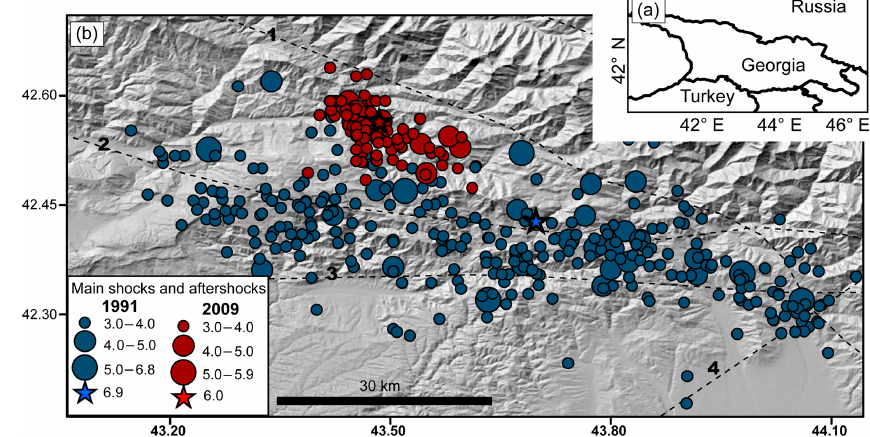
Figure 1. (a) Location of Georgia. (b) Distribution of locations of the Racha main shocks (stars) and aftershocks from 1991 (dark blue dots) and 2009 (dark red dots) with magnitudes greater than 4 (source: the catalog of the Seismic Monitoring Center (SMC) in Georgia, www.seismo.ge). Major faults are shown by black dashed lines (Gamkrelidze and Shengelia, 2007). Numbers on the dashed lines link to the name of the faults. 1. Frontal over thrust of the Caucasus (kinematics: nappes fault), 2. Gagra–Java (kinematics: right-reverse slip